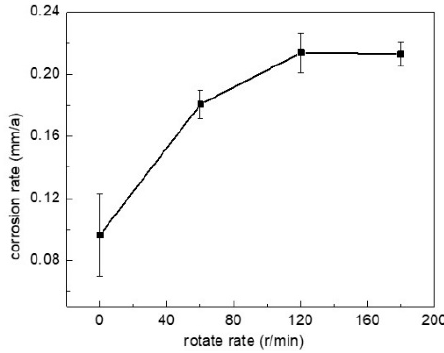
Figure 3. Weight loss rates of the specimens of P110 steel.